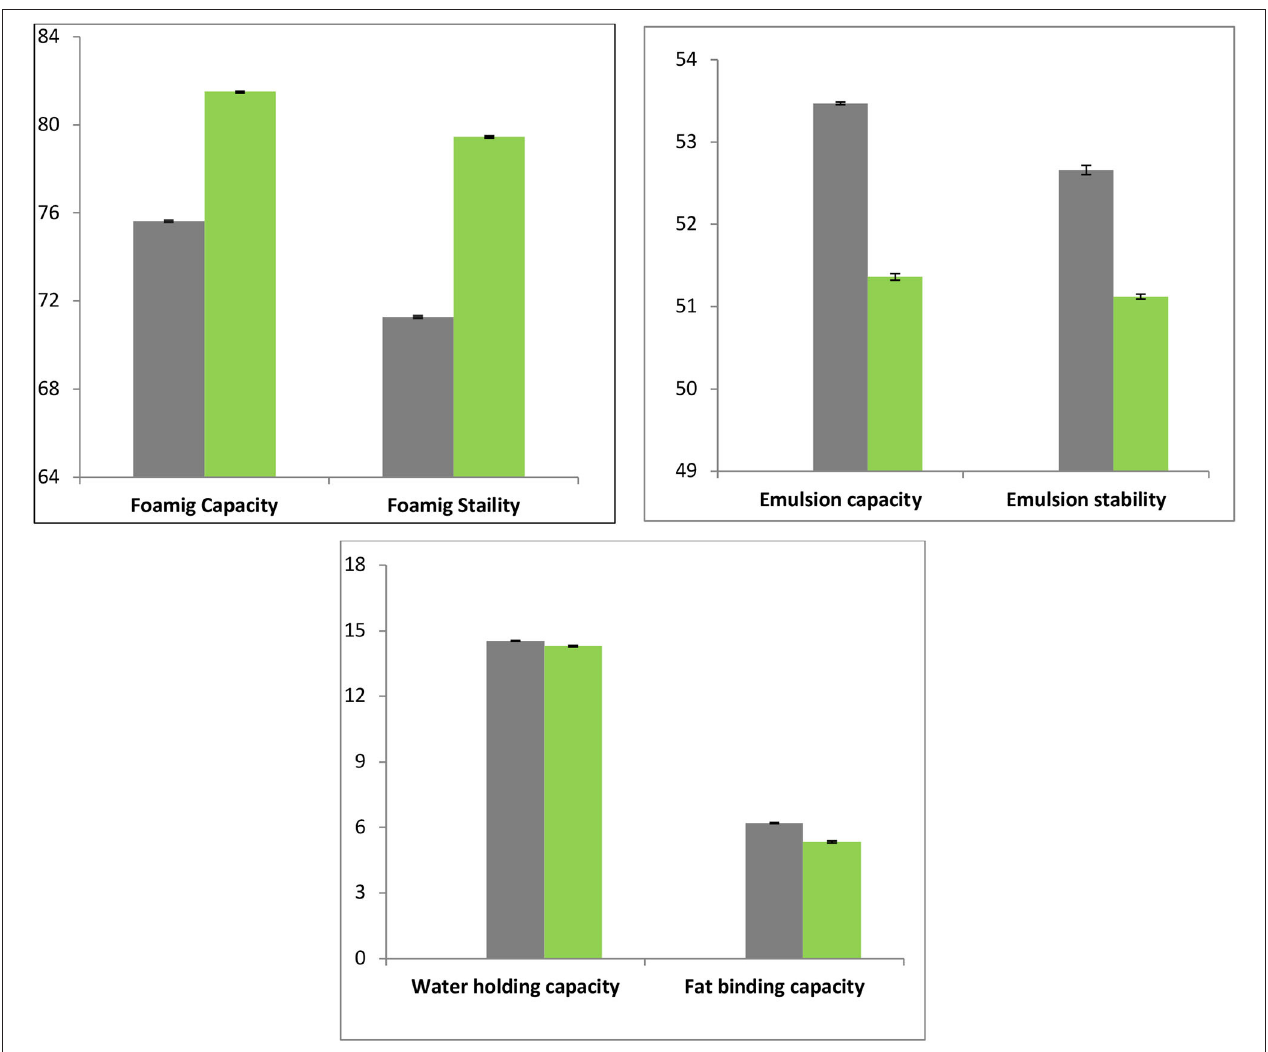
FIGURE 6 | Physicochemical and functional properties of FD ( ) and HAD ( )